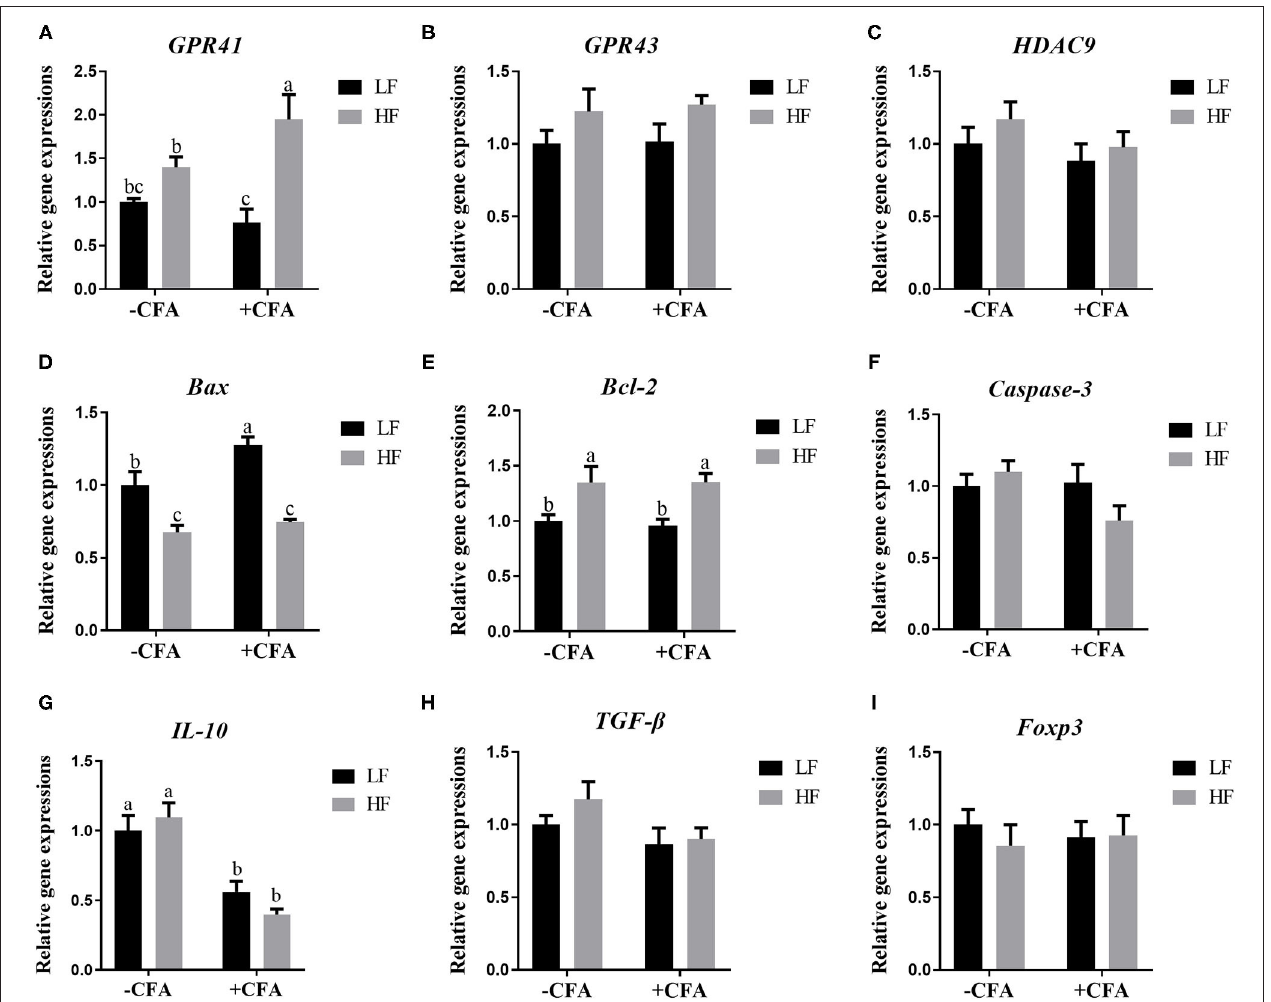
FIGURE 9 | Relative mRNA abundance in the lung of piglets fed diets supplemented with fiber following CFA challenge. (A) GPR41, G protein-coupled receptor 41; (B) GPR43, G protein-coupled receptor 43; (C) HDAC9, Histone deacetylase 9; (D) Bax, BCL2-Associated X; (E) Bcl-2, B cell lymphoma 2; (F) Caspase-3, Cysteine-requiring aspartate protease 3; (G) IL 10, Interleukin 10; (H) TGF- β ; transforming growth factor- β ; (I) Foxp3, Forkhead box P3. Values are means, with their standard errors represented by vertical bars. a,b Mean values with unlike letters were significantly different ( p <